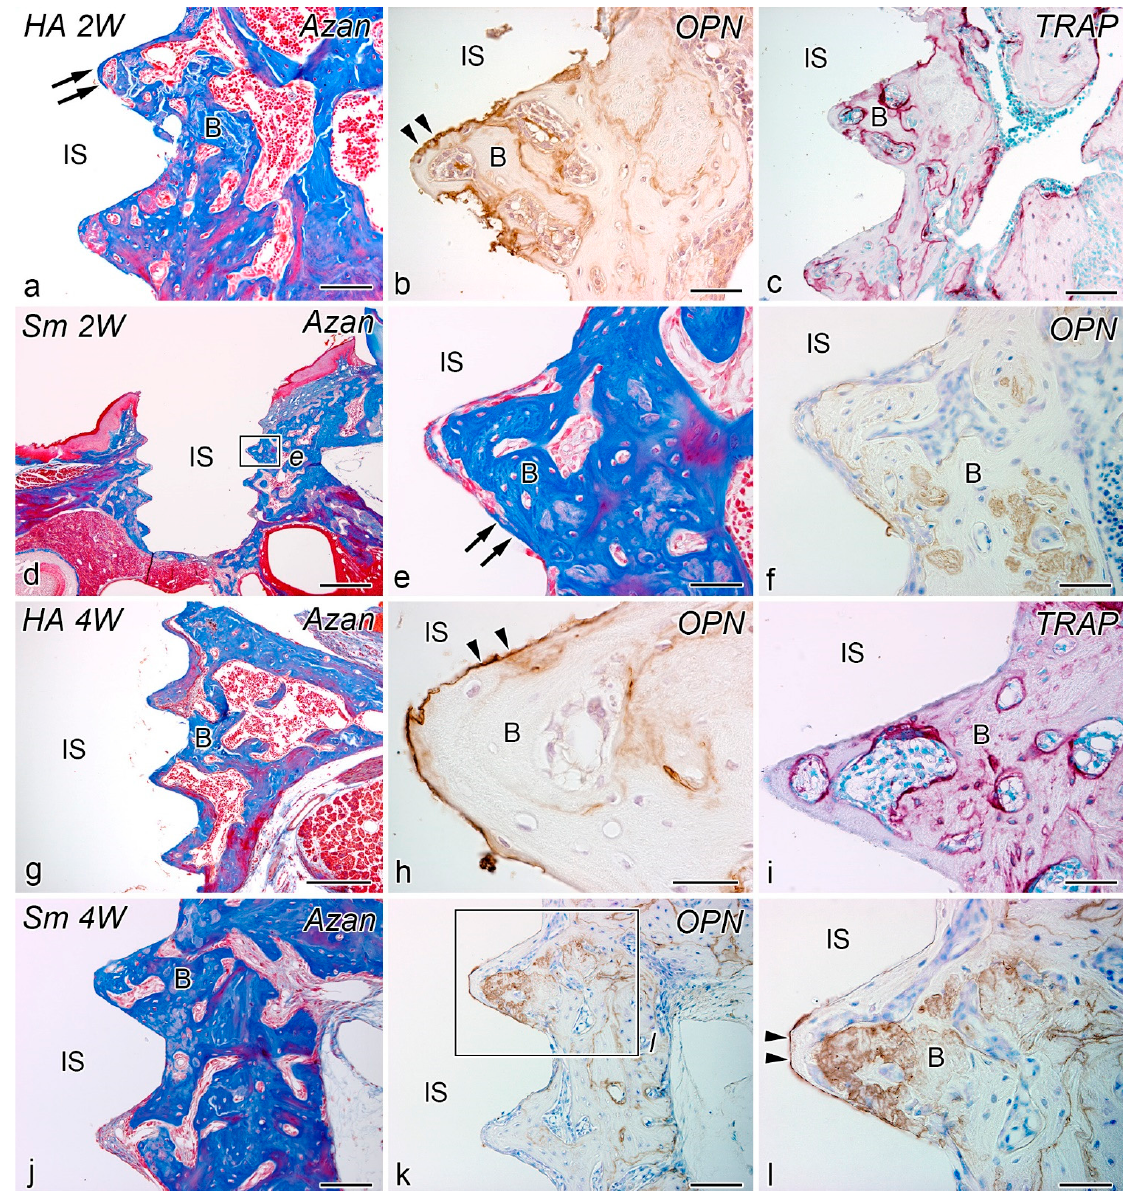
Figure 3. Azan staining ( a , d , e , g , j ), TRAP reaction ( c , i ), and OPN-immunoreactivity ( b , f , h , l ) in tissues surrounding the implants in the HA ( a – c , g – i ) and Sm groups ( d – f , j – l ) at week 2 ( a – f ) and 4 ( g – l ) after implantation. ( e ) and ( l ) are higher magnifications of the boxed areas in ( d ) and ( k ), respectively. ( a – l ) Progressive bone formation occur over the entire implant. OPN-positive reactions (arrowheads) are observed in the bone-implant interface at the site of bone formation, and TRAP-positive reactions are observed in the new bone. (l) is the higher magnification of the boxed area in ( k ). Arrows, direct osteogenesis; B, bone; IS, implant space. Scale bars = ( d ) 500 μ m, ( g ) 250 μ m, ( a , c , j , k ) 100 μ m, and ( b , e , f , h , i , l ) 50 μ m.